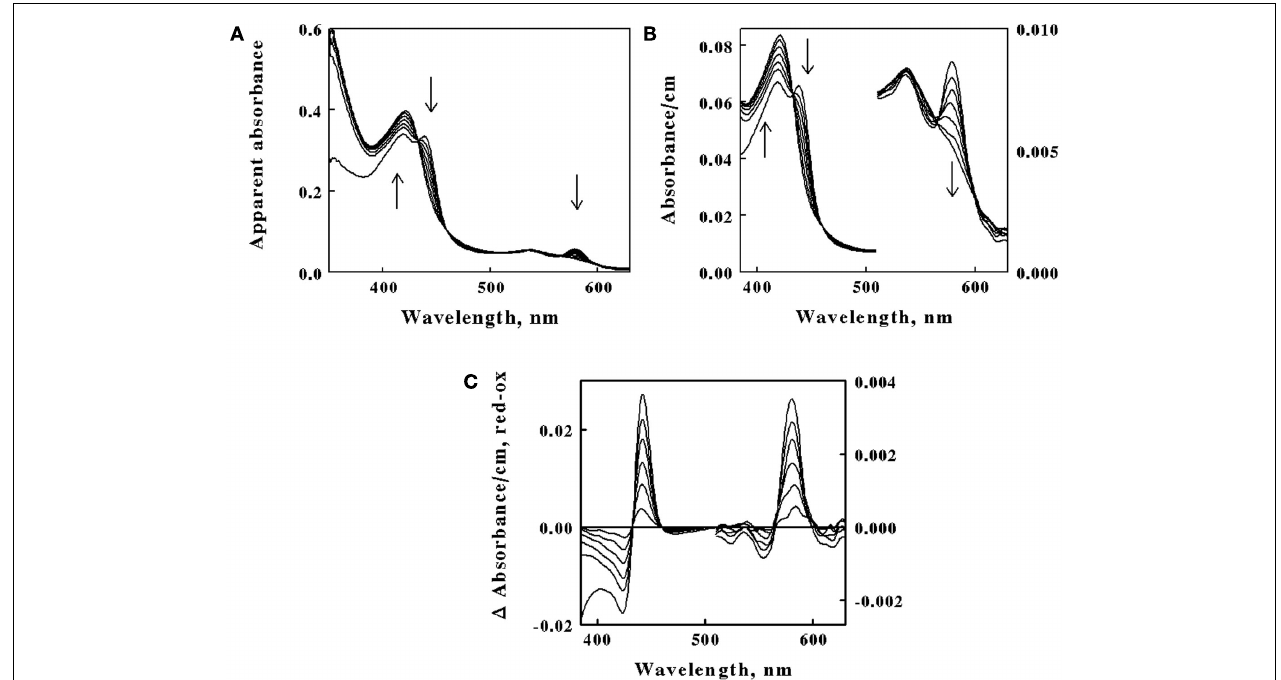
were converted to equivalent absorbance values per cm using the Fry equation (see text) to adjust for mean path length differences at different wavelengths.The absorbances at the longer wavelengths correspond to the more sensitive scale shown on the right ordinate. (C) Difference spectra, representing the absolute spectrum of the iron-reduced L. ferrooxidans minus those obtained at selected time points following the initial reduction of the